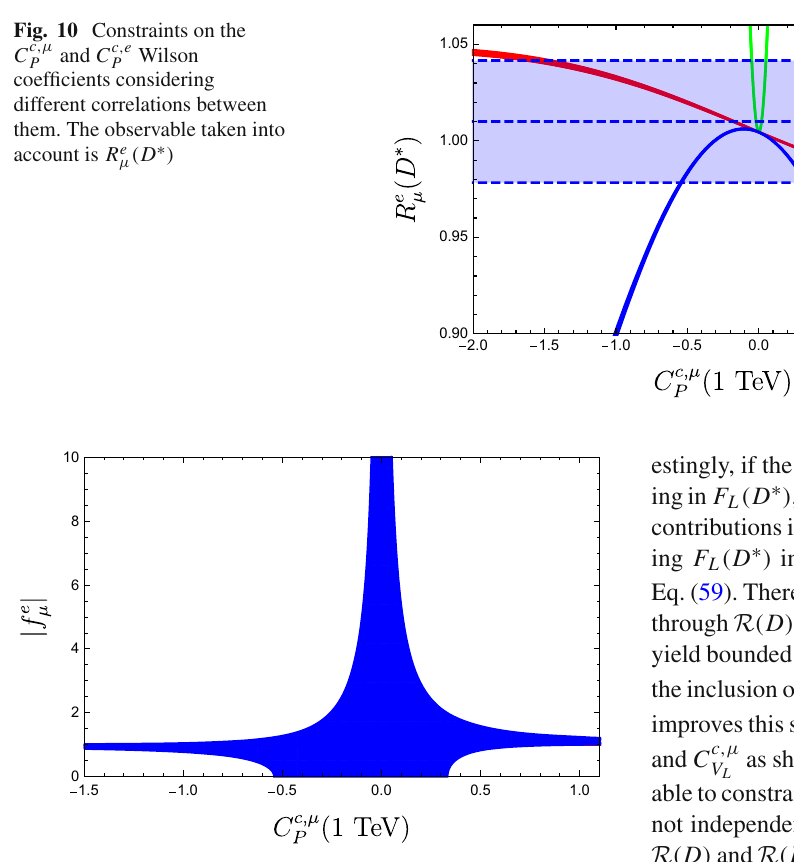
Fig. 11 Correlation following from Eq. (66) between C c NP enhancement factor f e μ , the latter relating the former with C c , e defined through Eq.